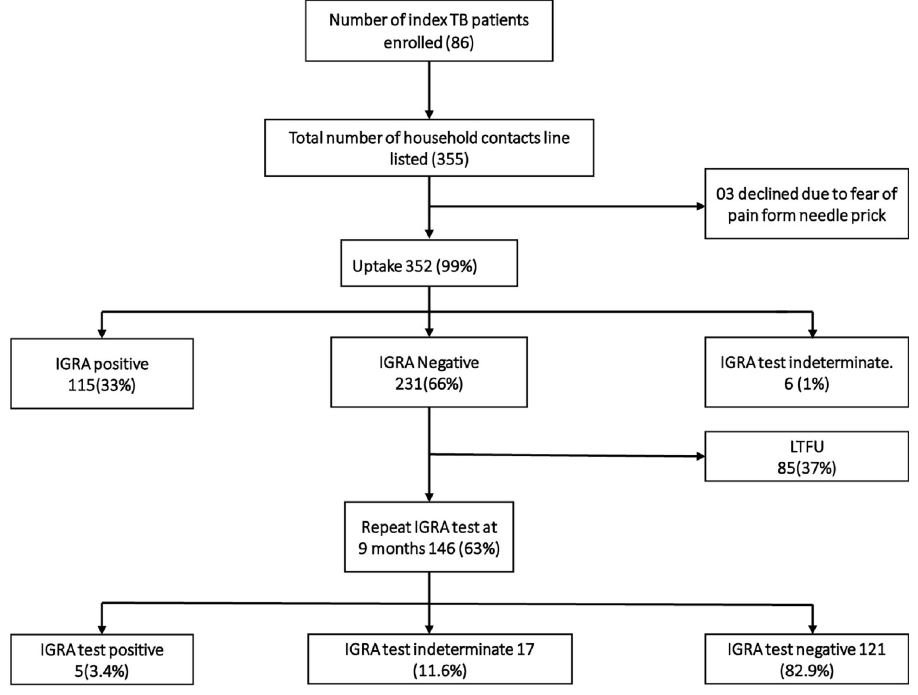
Fig 2. A consort diagram showing participants’ flow during study